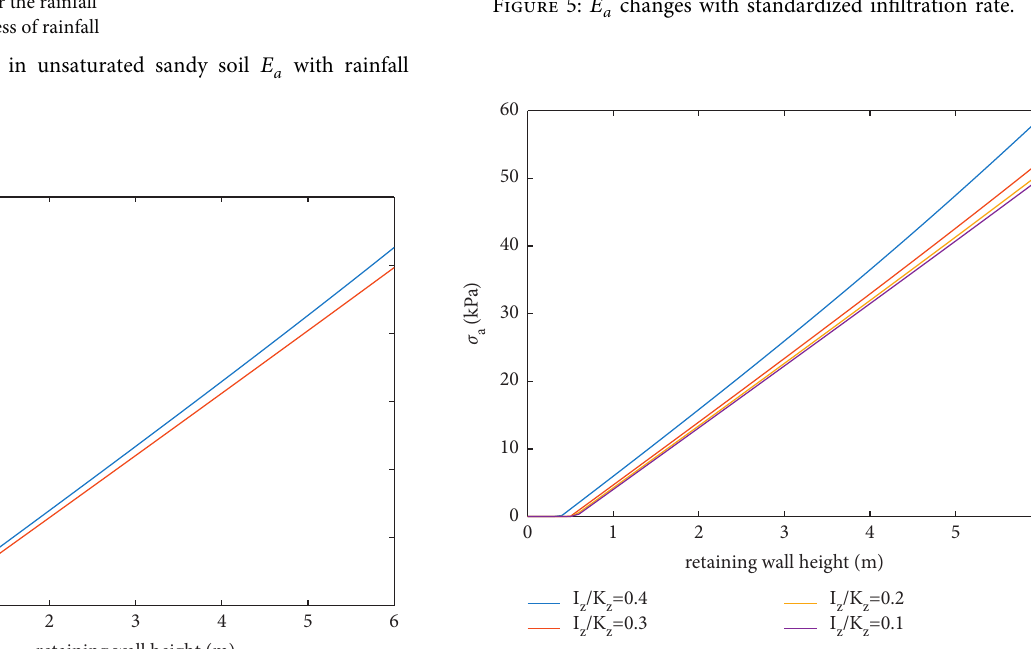
Figure 6: Changes in σ p at different marking infiltration